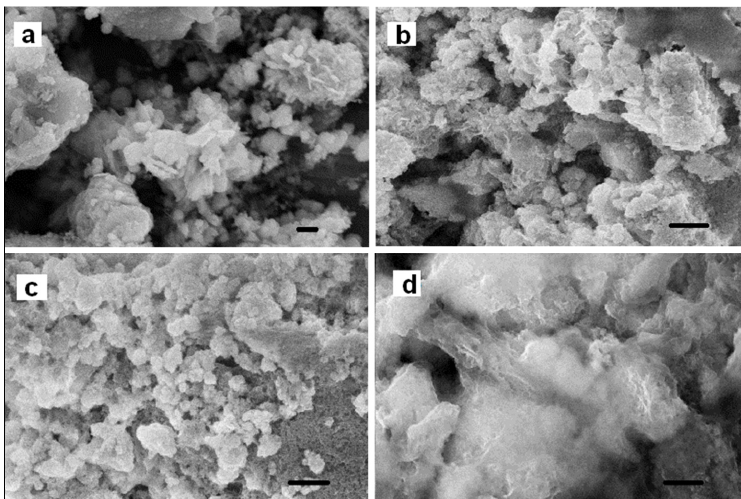
Figure 1. Scanning electron microscopy (SEM) micrographs of: ( A ) Sieved zero ‐ valent iron (ZVI) sample; ( B ) Polyhydroxybutyrate (PHB) ‐ ZVI complex with PHB/ZVI ratio 2:1 ( w / w) ; ( C ) PHB ‐ ZVI complex with PHB/ZVI ratio 1:1 ( w / w) ; ( D ) PHB ‐ ZVI complex with PHB/ZVI ratio 1:2 ( w / w) . Scale bars represent 200 nm.